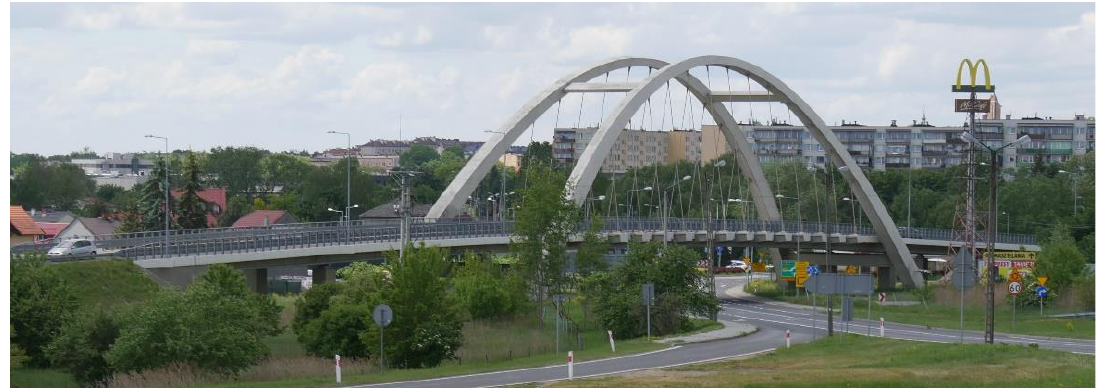
Appl. Sci. 2022 , 12 , x FOR PEER REVIEW Figure 2. The analyzed bridge located in Chrzanów, Southern Poland. Figure 2. The analyzed bridge located in Chrzan ó w, Southern Poland.